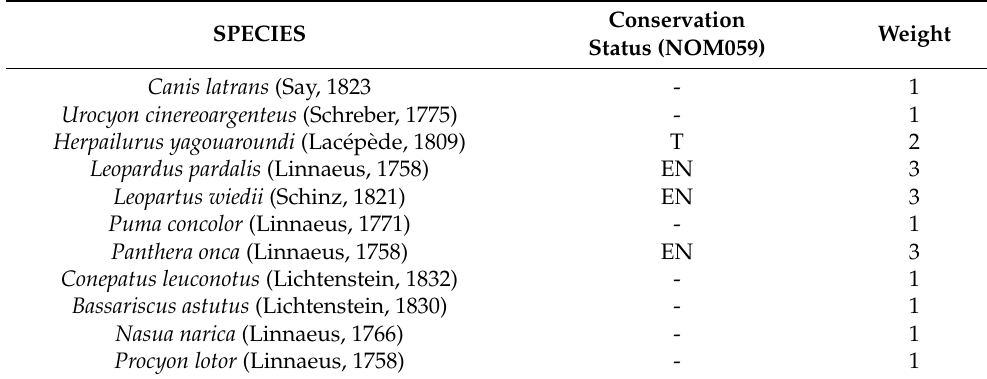
Table 3. Weights assigned to each species in the prioritization of conservation areas. A higher weight represents the highest level of concern considered by the prioritization algorithm